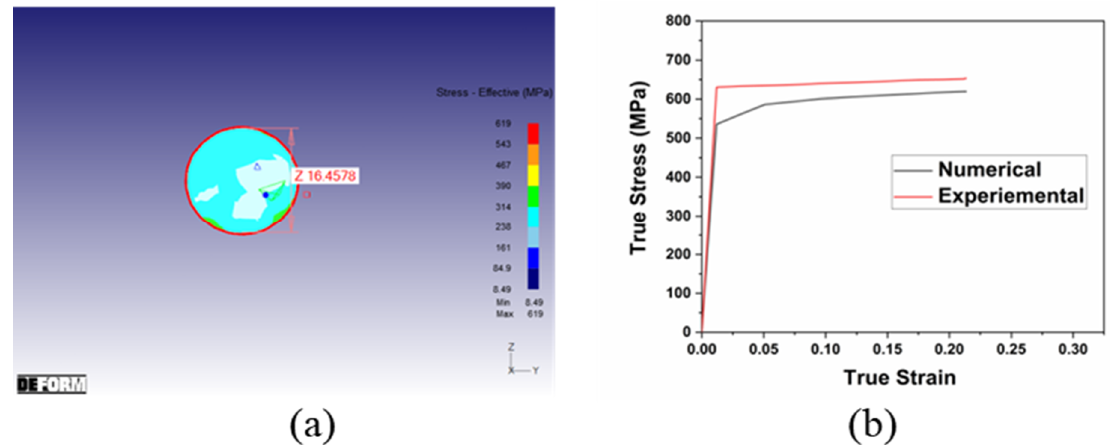
Figure 8. ( a ) The cross section of the 16.2 mm rod, and ( b ) the comparison of numerical and experimental true σ and ϵ curves of the swaged piece.